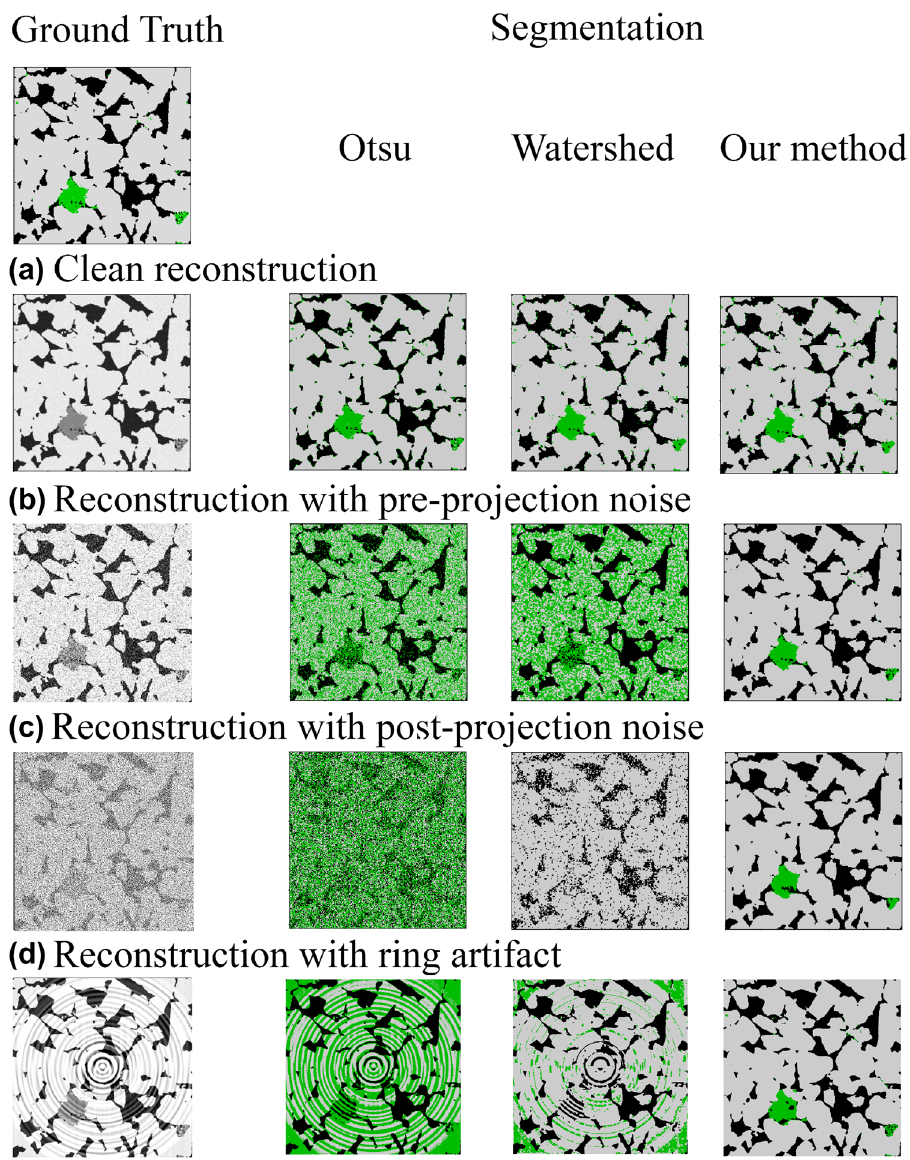
Figure 4. Comparison of segmentation results between Otsu, watershed and our method on four synthetic images corresponding to: ( a ) clean filtered back reconstruction, ( b ) reconstruction with noise pre-projection, ( c ) reconstruction with noise post-projection, and ( d ) reconstruction with ring